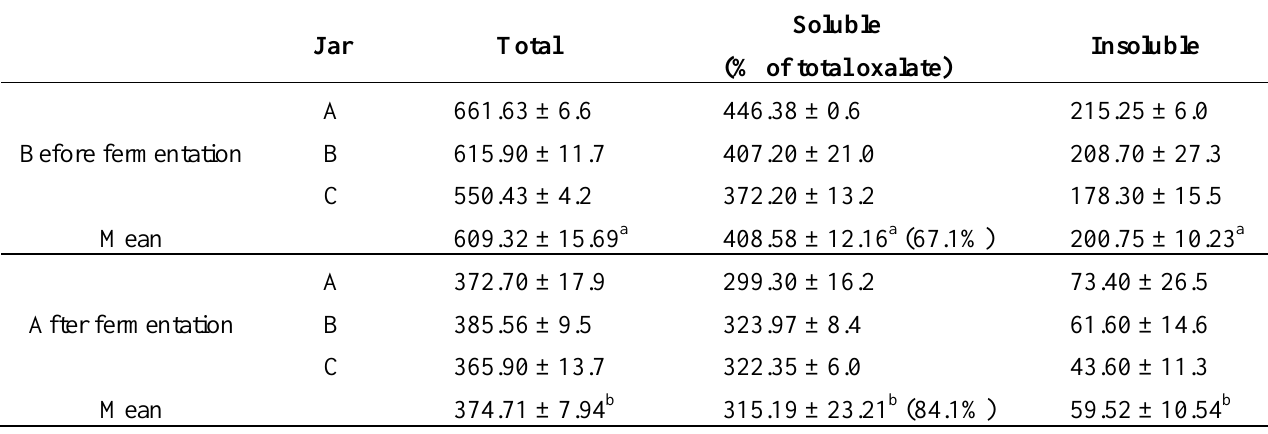
Table 4. Mean total soluble and insoluble oxalate contents of kimchi before and after fermentation (mg/100 g